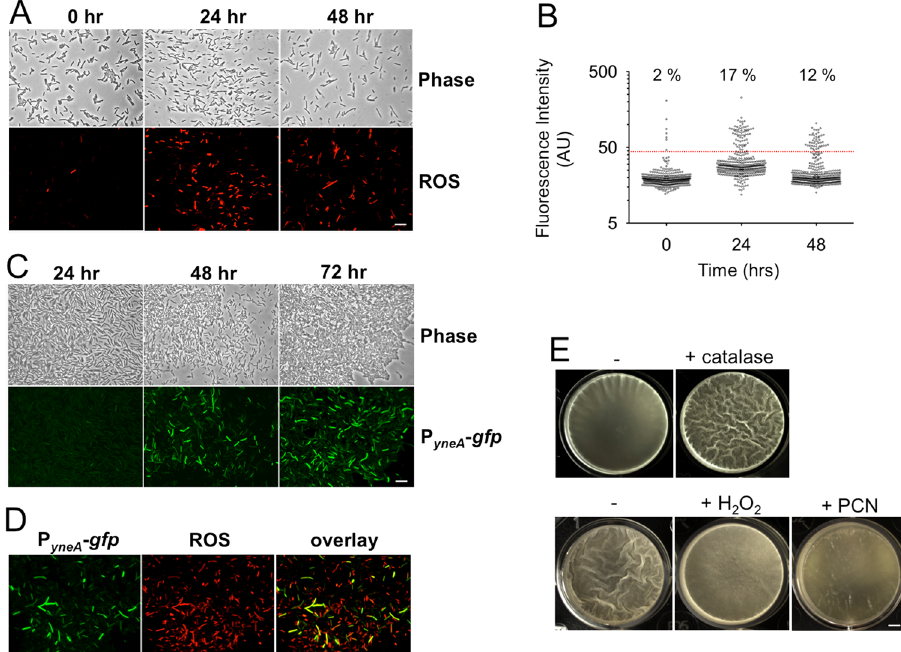
Fig. 1 ROS accumulation triggers the DNA damage response (DDR) in a subpopulation of cells in a B. subtilis bio fi lm. a Older bio fi lms accumulate ROS. B. subtilis NCIB 3610 cells collected from 0, 24, and 48 h bio fi lm pellicles were treated with a superoxide-speci fi c dye and observed under fl uorescent microscopy. Cells with strong superoxide accumulation show a red color . Scale bar represents 10 μ m. b There is an increase in ROS accumulation in cells from older bio fi lms. Quanti fi cation of cells from a was performed using ImageJ. 44 Each dot represents one cell and the y -axis shows fl uorescent intensity. The dotted horizontal line indicates the threshold used to de fi ne ROS ON cells (described in Methods). c Older bio fi lms accumulate DNA damage. B. subtilis YCN036 cells containing the P yneA - gfp DDR reporter were collected from 24, 48, and 72 h pellicle bio fi lms and observed under fl uorescent microscopy ( green cells ). Scale bar represents 10 μ m. d ROS ON cells and DDR ON cells overlap. Same cells applied in c were collected from 48 h pellicle bio fi lms and stained with superoxide-speci fi c dye ( red cells ). An overlay image of ROS ON cells (in red ) and DDR ON cells (in green ) is shown. Scale bar represents 10 μ m. e ROS negatively impacts B. subtilis bio fi lm development. In the top panels , the B. subtilis 3610 bio fi lm pellicles treated with catalase (1 mg ml − 1 ) was more robust than the one without treatment. Images were taken after 24 h of incubation. Bottom panels show that the pellicle bio fi lms treated with H 2 O 2 (0.001%, v/v) or pyocyanin (PCN) (2.5 μ g ml − 1 ) are much weaker than without treatment. Images were taken after 48 h of incubation. Scale bar represents